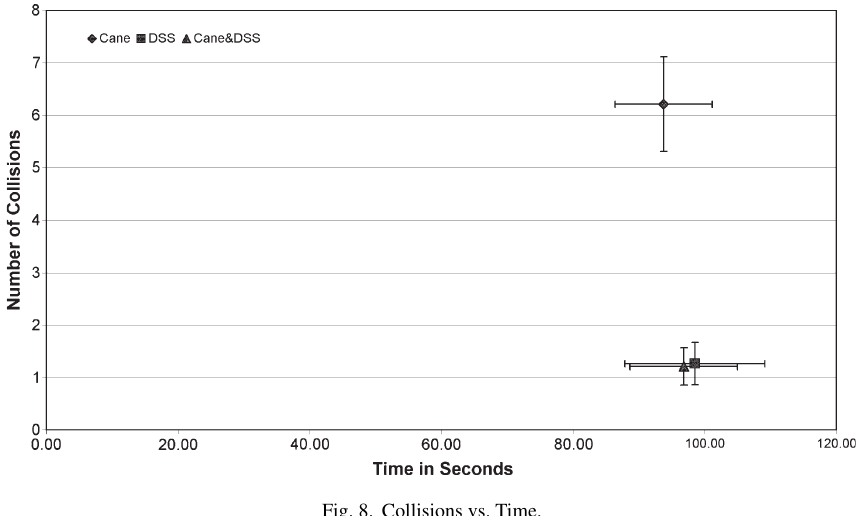
Fig. 8. Collisions vs.